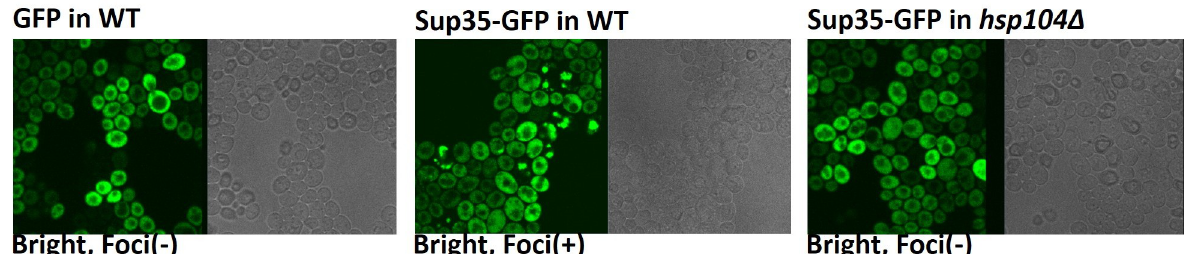
Fig 5. Trehalose stabilize and revive Sup35-GFP protein folding under stress conditions. Sup35-GFP in wild type and hsp104 Δ cells after 24 hours incubation in 5mM guanidium hydrochloride and 100mM trehalose.